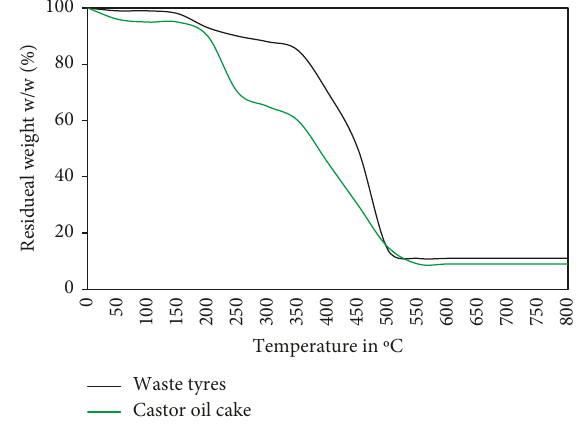
Figure 1: Thermogravimetric analysis of the feedstocks.